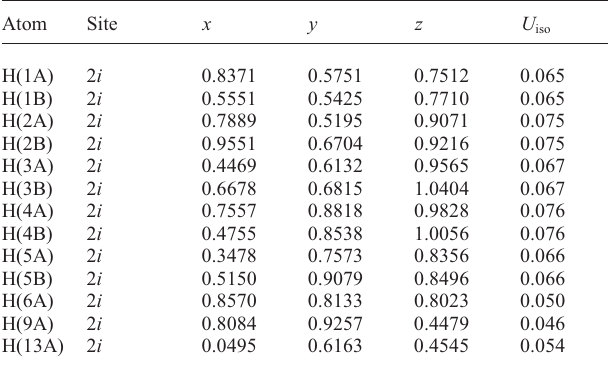
Table 2. Atomic coordinates and displacement parameters (in Å 2 )